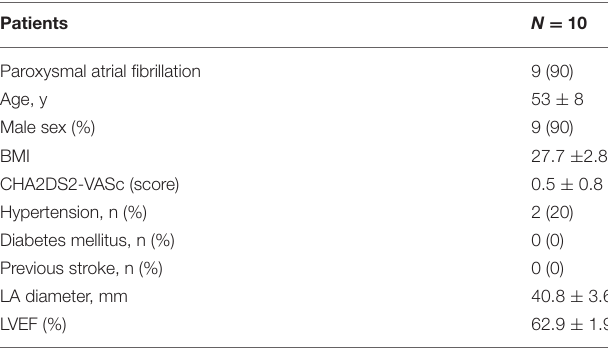
TABLE 1 | Baseline characteristics.